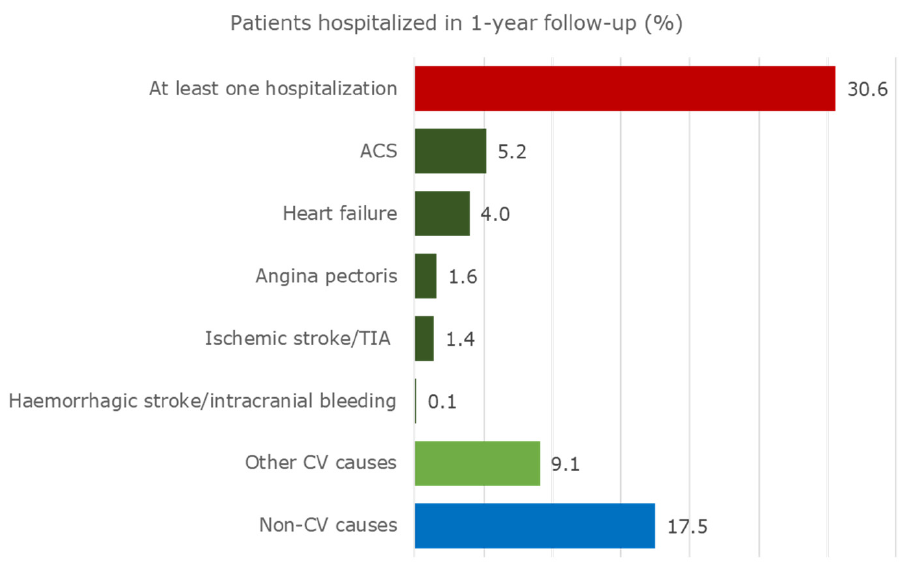
Figure 2. Hospitalizations of patients with CAD and eligible for CV secondary prevention drugs during the one-year follow-up.